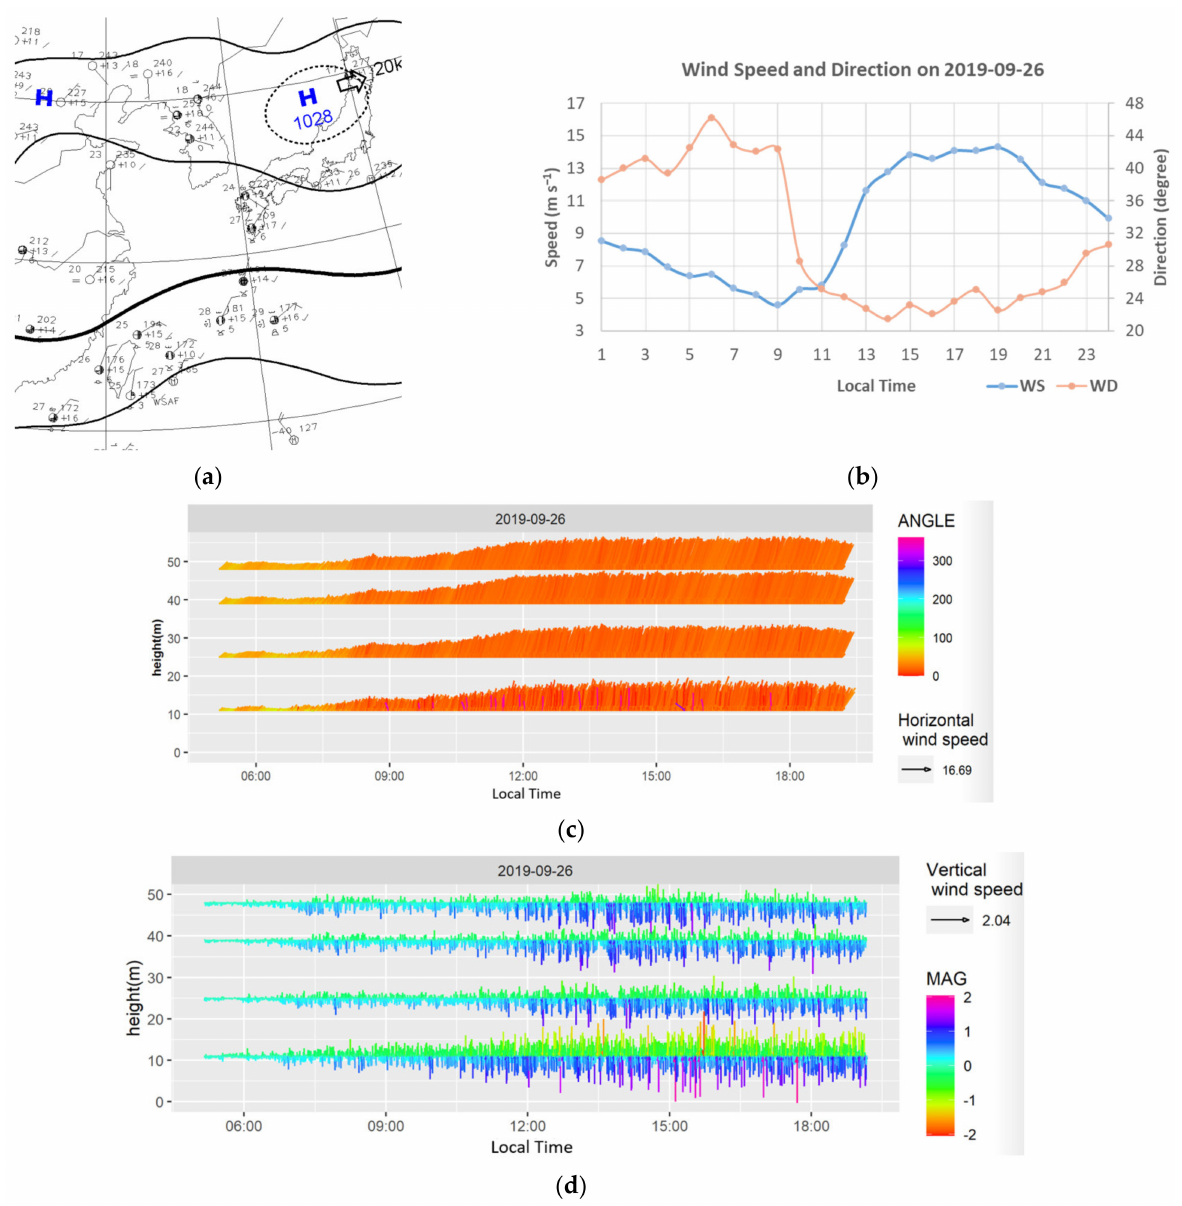
Figure 15. ( a ) The surface weather chart at 00:00 UTC on 26 September 2019 (corkscrew sea breeze). ( b ) Wind Speed (WS) and Direction (WD) at 100 m height on 26 September 2019 (corkscrew sea breeze). ( c ) Horizontal wind speed component of 11 m, 25 m, 39 m and 48 m on 26 September 2019 (corkscrew sea breeze). ( d ) Vertical wind speed component of 11 m, 25 m, 39 m and 48 m on 26 September 2019 (corkscrew sea